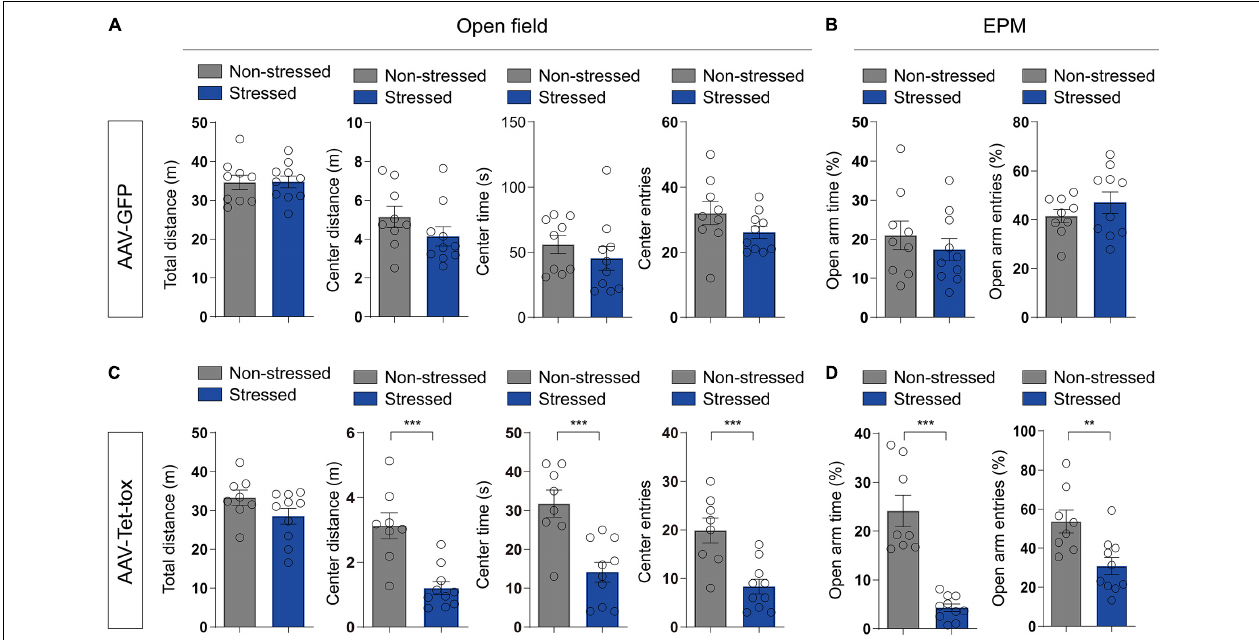
FIGURE 3 | Effect of ZI silencing on locomotion activity and anxiety. (A,C) The total distance in open filed, and the distance, time and number of entries in the middle area of the open field were recorded in mice. The stressed mice in AAV-GFP group did not show marked changes in locomotion activity and anxiety level, whereas the stressed mice in AAV-Tet-tox group showed marked anxiety-like behavior, but had no change in locomotion activity. The two-tailed unpaired t -test was used to compare the behavioral parameters of OFT in non-stressed and stressed groups. (B,D) The percentages of time and entries in the open arms of EPM were recorded in mice. The stressed mice in AAV-GFP group did not show marked changes in anxiety level, whereas the stressed mice in AAV-Tet-tox group showed marked anxiety-like behavior. The two-tailed unpaired t -test was used to compare the behavioral parameters of EPM test in non-stressed and stressed groups. ** P < 0.01, *** P <